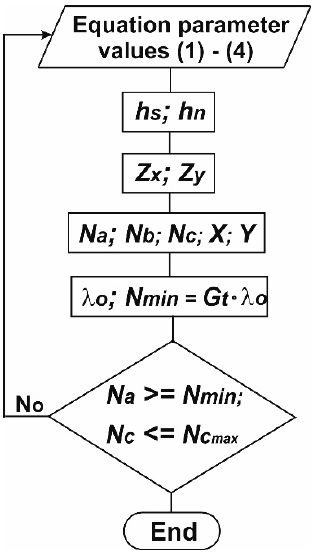
Figure 4. Block diagram of the calculation algorithm.